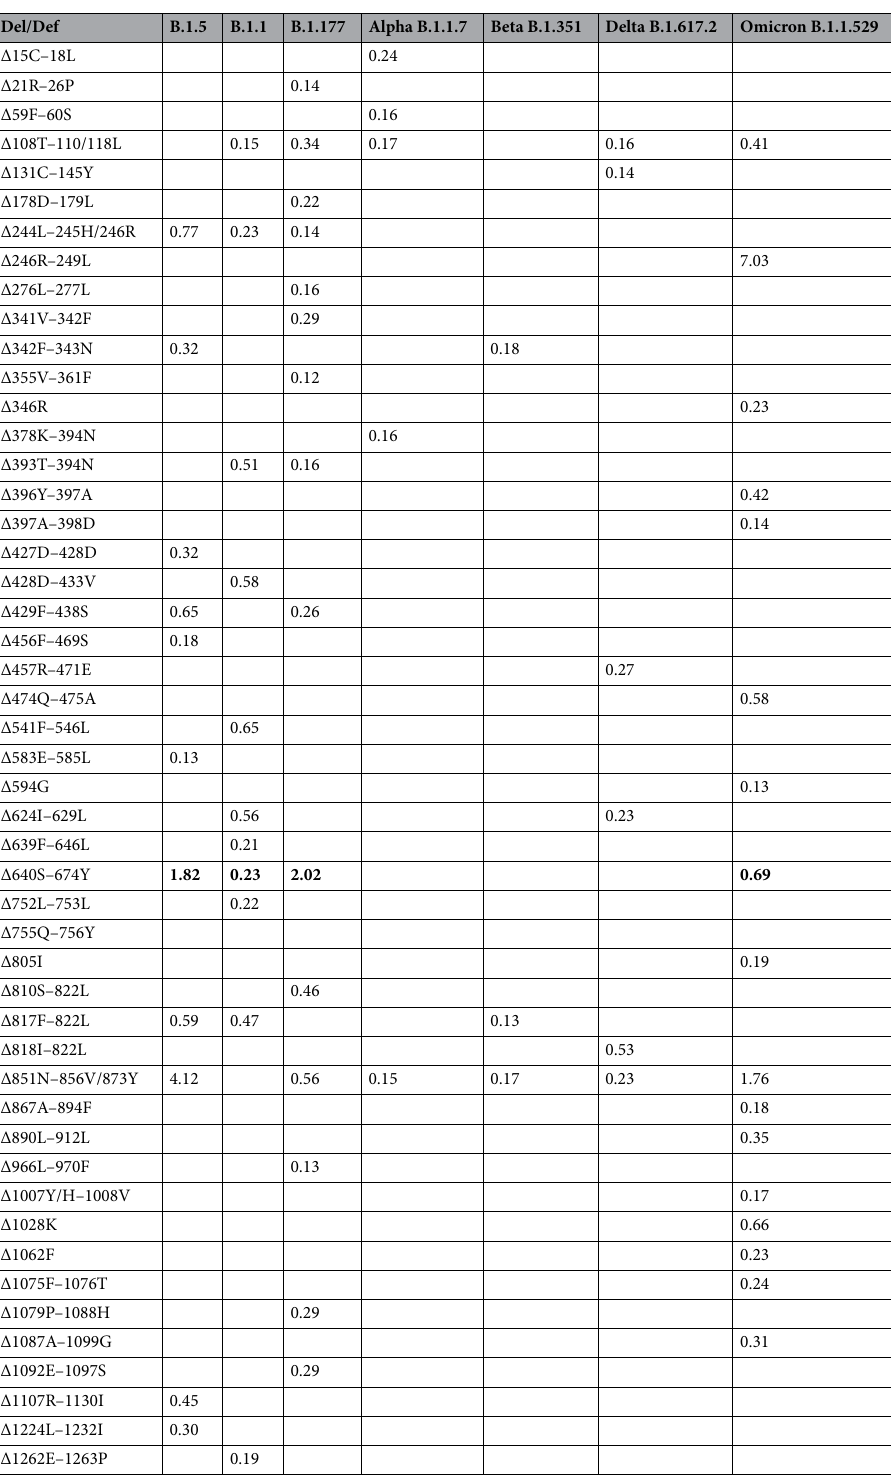
Table 8. Population frequency of defective genomes per deleted amino acid position (Del/Def) and variant. Del = deletion; Def = deletions that cause a defective genome. The bold indicates the region where defective deletions were prevalent in different patients infected with variants at the beginning of the pandemic and in